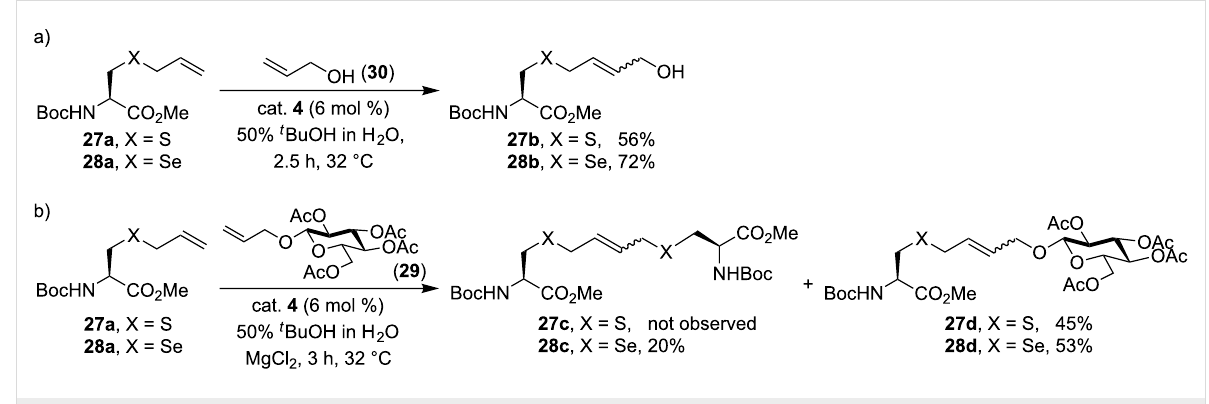
Scheme 11: Comparison of reactivity between allyl sulfides and allyl selenides in aqueous cross-metathesis